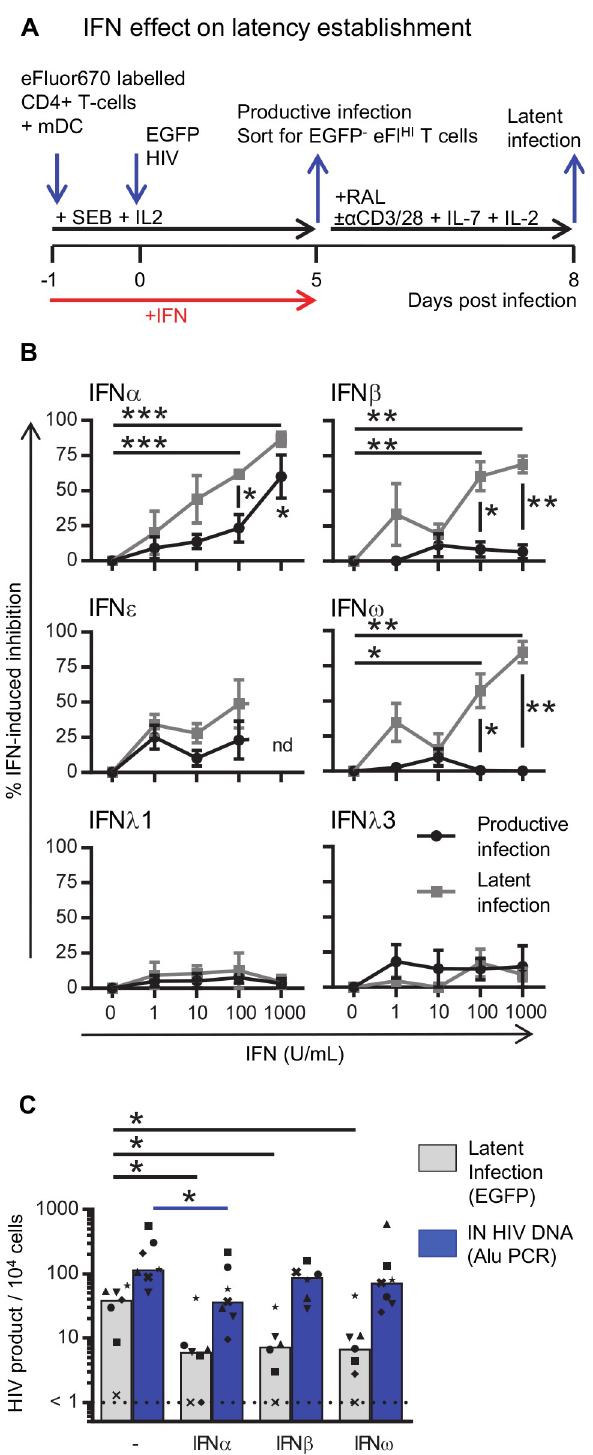
Fig 2. IFN-induced inhibition of productive infection and establishment of latent infection. A: Experimental design to determine the effect of IFN on productive and latent infection. B: Resting CD4 + T cells were co-cultured with mDC in the absence or presence of IFN (1–1000 U/mL, as indicated) and the IFN-induced inhibition was calculated for productive (black circles) and latent (grey squares) infection. C: Resting CD4 + T cells were co-cultured with mDC in the absence and presence of 100 U/mL IFN α , IFN β or IFN ω . Cells were infected and sorted as described in A